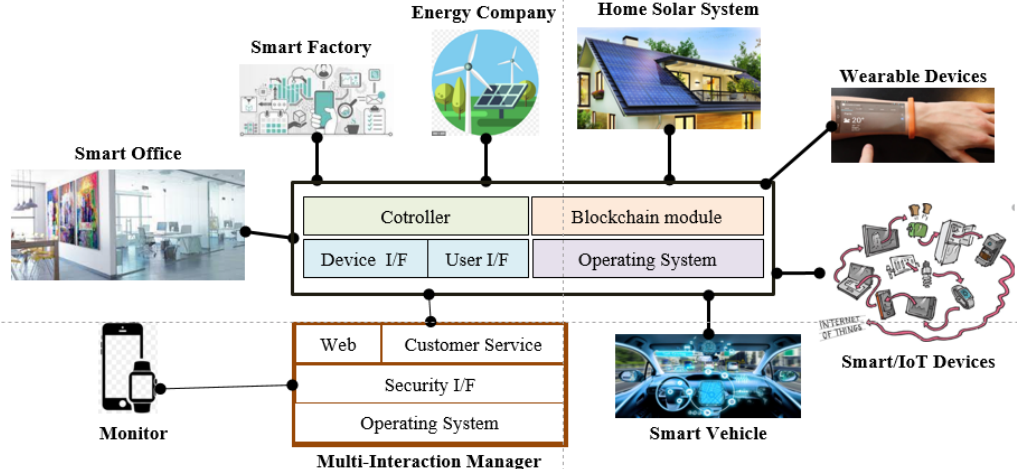
Figure 2. Energy Network for an Energy Trade